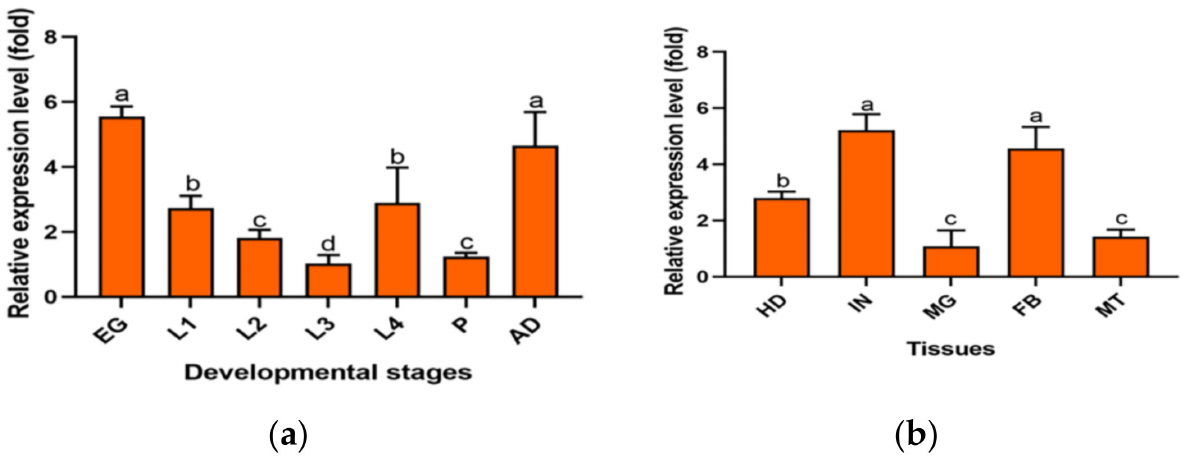
Figure 3. Spatiotemporal expression profiles of the PxMetAP1 gene in the G88 strain. ( a ) EG, egg; L1, 1st instar larvae; L2, 2nd instar larvae; L3, 3rd instar larvae; L4, 4th instar larvae; P, pupae; AD, adults. ( b ) HD, head; IN, integument; MG, midgut; FB, fatbody; MT, Malpighian tubules. One-way ANOVA was used for the comparison of significant differences in different developmental stages and tissues, and the LSD method was used for multiple comparisons. Different letters denote significant differences ( p <